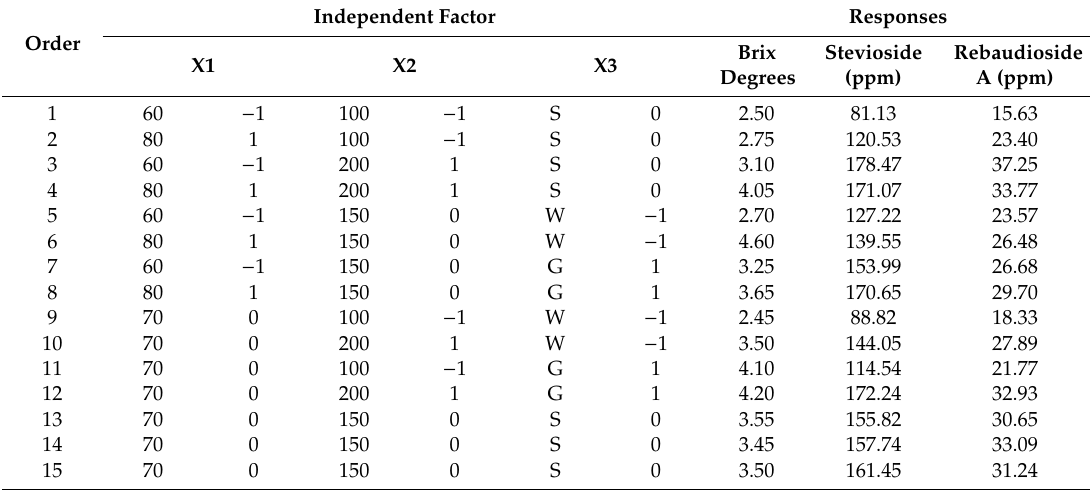
Table 3. Experimental design runs for Box-Behnken design and experimental values of responses.